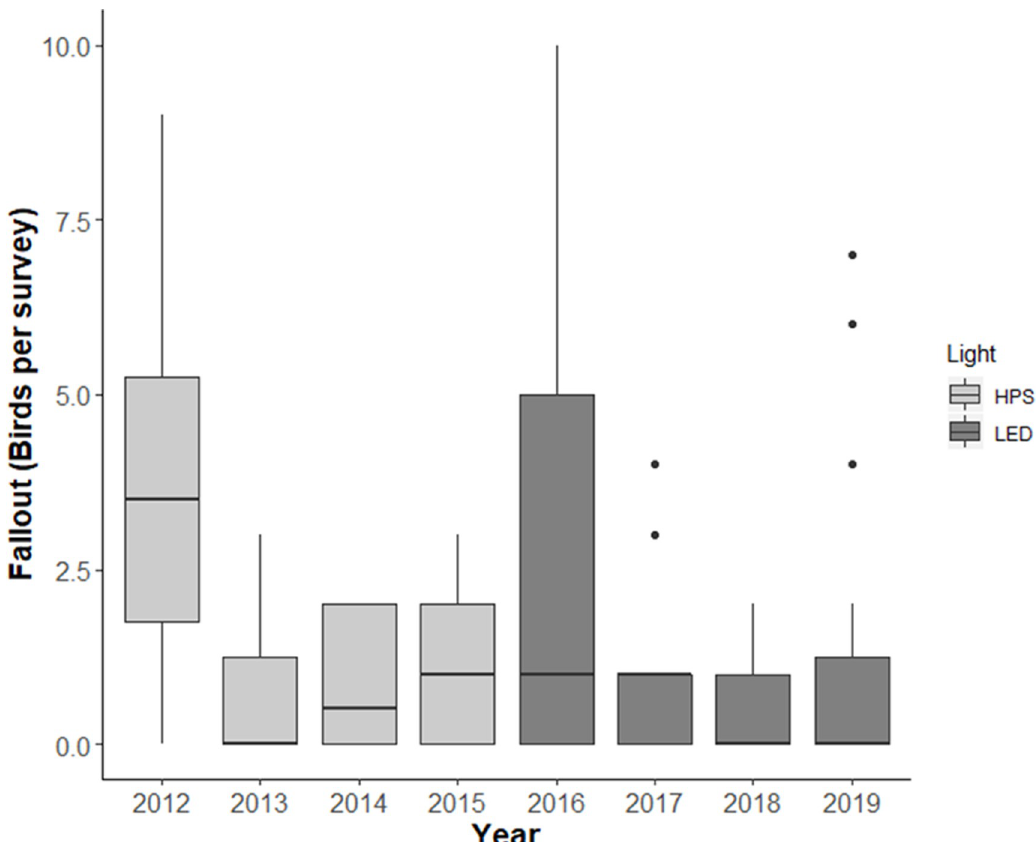
Fig 3. Boxplots of WTSH carcasses observed during road surveys. Distribution (5, 25, 50, 75, 95 percentiles) of the number of grounded WTSH observed each study year (n = 16 yearly surveys). Dots indicate outliers.